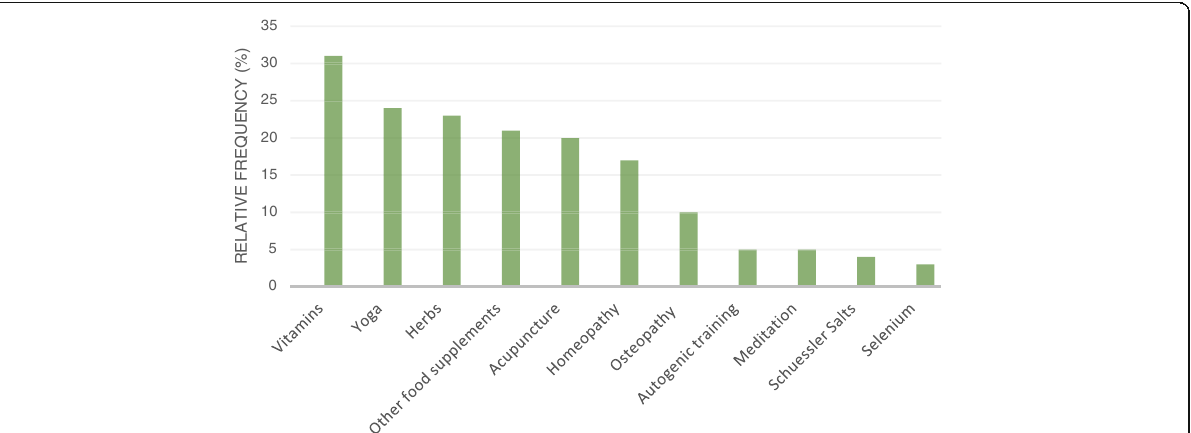
Fig. 1 Relative frequencies of most commonly used CAM modalities and relaxation therapies during pregnancy. Relative frequencies are reported in relation to the total sample size ( n = 394). Multiple responses were